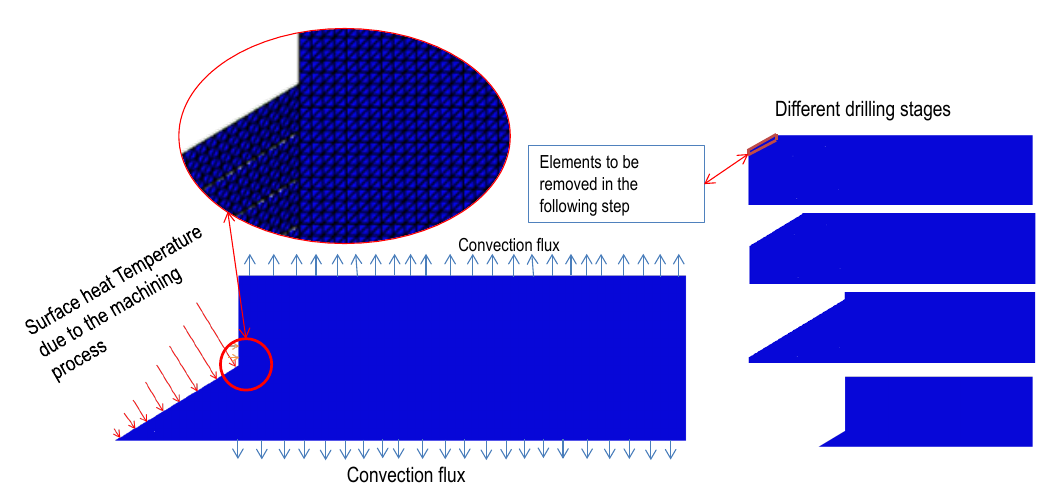
Figure 5. Scheme of the numerical